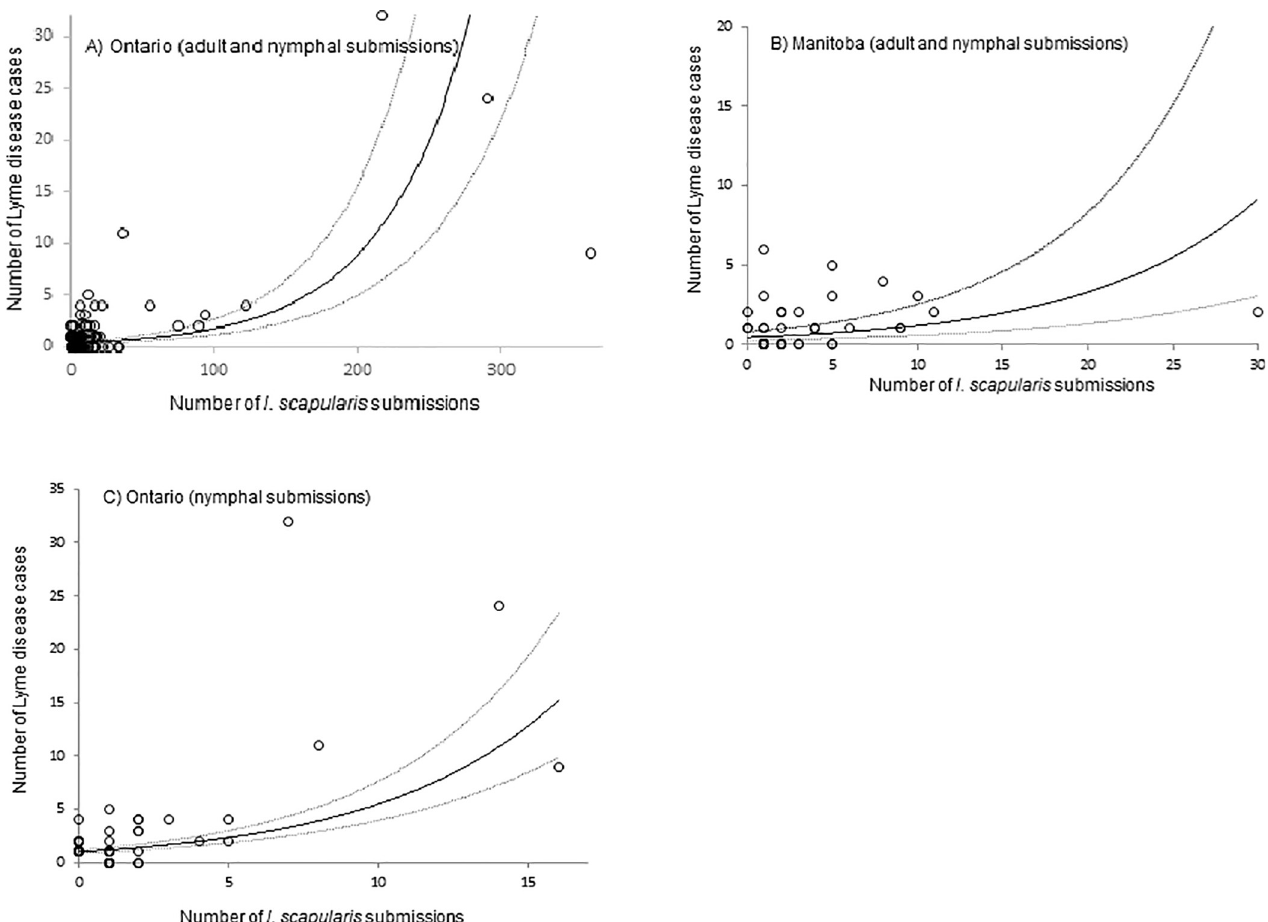
Fig 1. Negative binomial generalized estimating equation models of the relationship between the numbers of passive single I . scapularis tick submissions and reported Lyme disease cases per CSD, over 2 years. Numbers of tick submissions for all I . scapularis (adults and nymphs) in Ontario and Manitoba are illustrated respectively in A and B, whereas the numbers of nymphal tick submissions for Ontario are shown in C. The numbers of reported Lyme disease cases per CSD are illustrated by the circles and the model prediction by the solid line (dashed lines show the 95% confidence limits for the fitted model). Note that there are differences in the axis scales between the